Question: Write the caption for this figure.
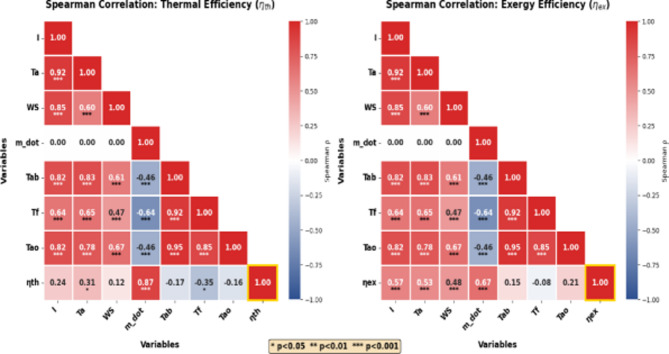
Answer: Spearman heatmaps for thermal and exergy efficiencies.